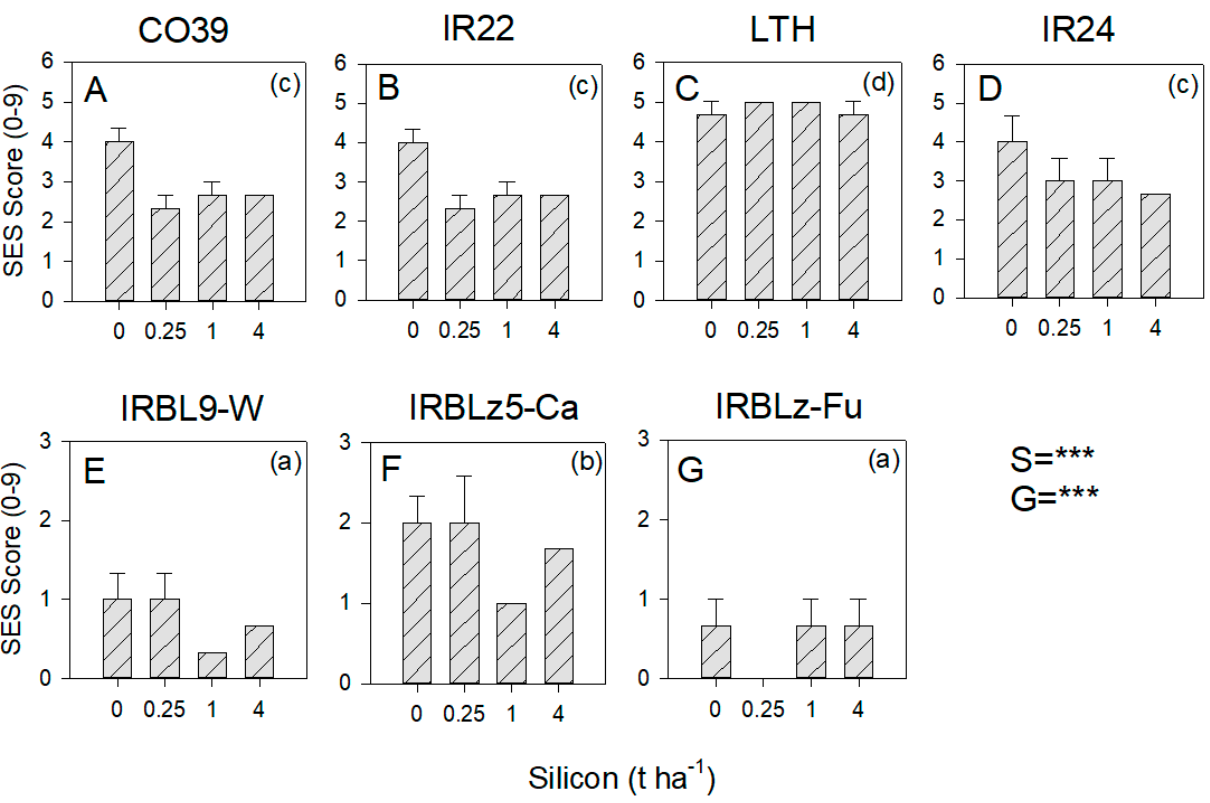
Figure 5. Effects of soil silicon on blast disease in 7 rice varieties: Varieties ( A ) CO39, ( B ) IR22, ( C ) LTH, ( D ) IR24 were susceptible to blast, whereas varieties ( E ) IRBL-W, ( F ) IRBLz5-Ca, and ( G ) IRBLz-Fu were resistant to blast. Blast incidence was evaluated using the Standard Evaluation System (SES) for leaf blast. Soil was amended with 0, 0.25, 1 and 4 t ha − 1 equivalents of silicon. Standard errors are indicated (sample size = 3). Summary statistics for the univariate general linear model are indicated as S = silicon level interaction, G = rice genotype, and *** = p ≤ 0.005; lowercase letters in parentheses indicate homogenous variety groups; note differences in scales. See also Table S9.